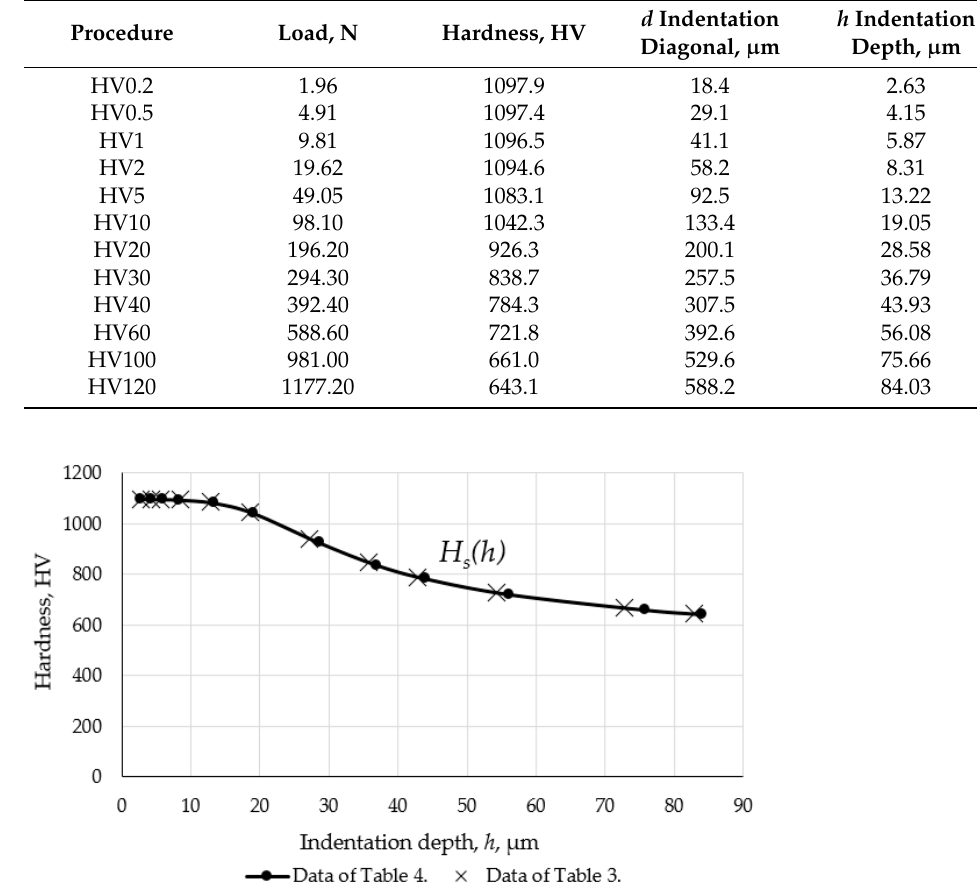
Figure 5. Relationship of h indentation depth and surface hardness ( H s ( h )).